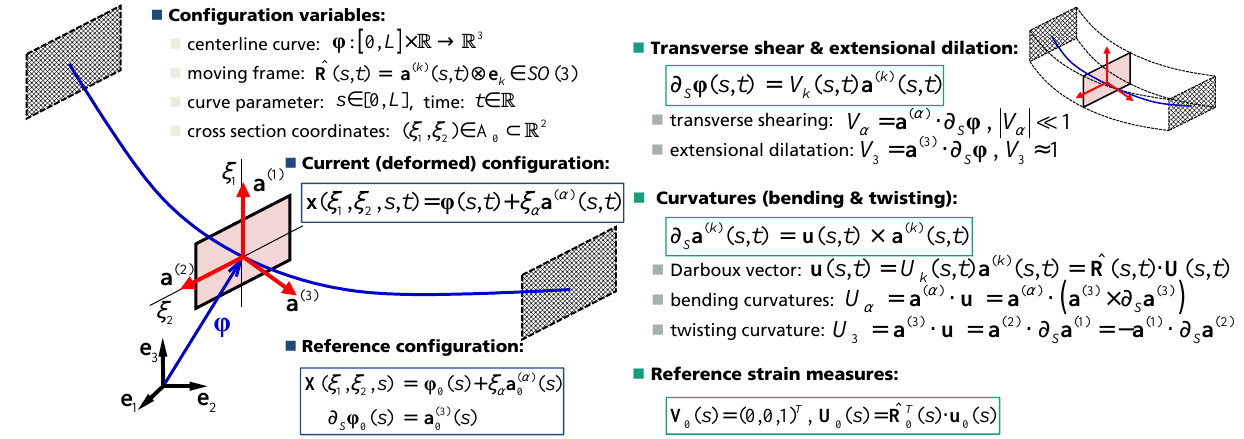
Figure 1. Left: kinematic quantities for the (deformed) current and (undeformed) reference configurations of a Cosserat rod. Right: strain measures of a Cosserat rod for transverse shearing, extensional dilatation, bending and twisting.